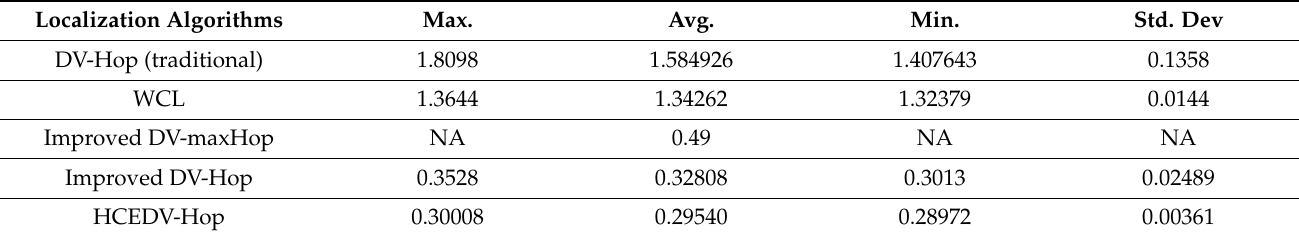
Table 7. Average localization